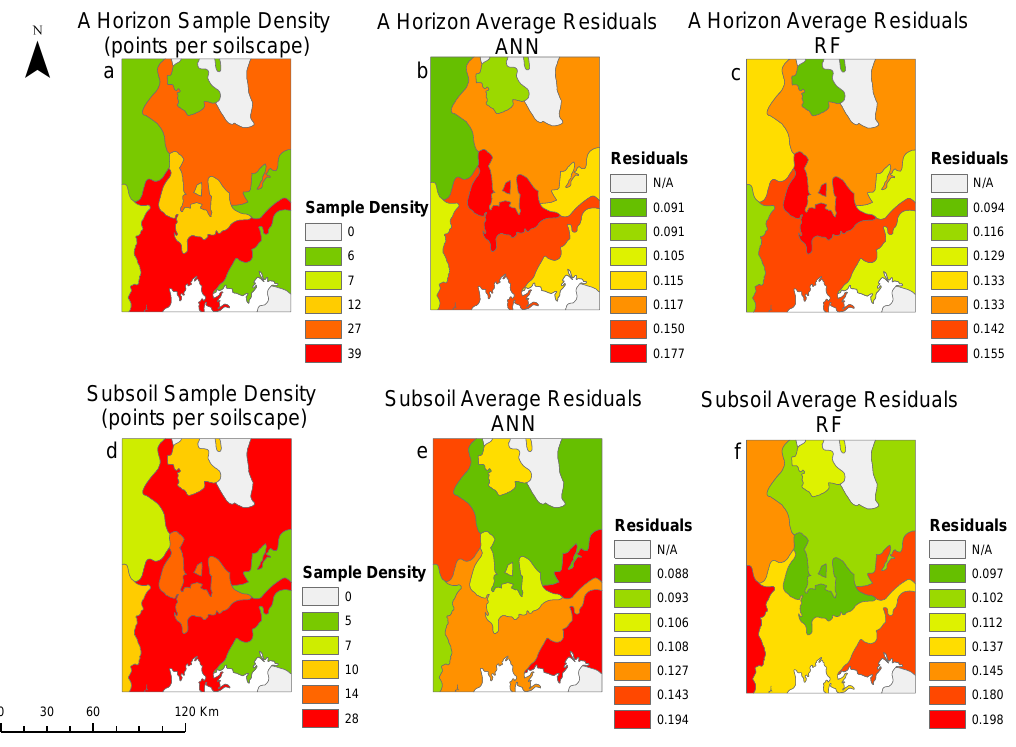
Figure 3: Spatial variation in model performance by Soilscape. a) The sample density for A 794 Fig. 3. Spatial variation in model performance by soilscape. (a) The sample density for A horizon samples. (b) Average residuals for the horizon samples b) Average residuals for the ANN model prediction in the A horizon c) 795 ANN model prediction in the A horizon. (c) Average residuals for the RF model prediction in the A horizon. (d) The sample density for Average residuals for the RF model prediction in the A horizon d) The sample density for 796 subsoil horizon samples. (e) Average residuals for the ANN model prediction in the subsoil horizon. (f) Average residuals for the RF model prediction in the subsoil subsoil horizon samples e) Average residuals for the ANN model prediction in the subsoil 797 horizon f) Average residuals for the RF model prediction in the subsoil horizon 798